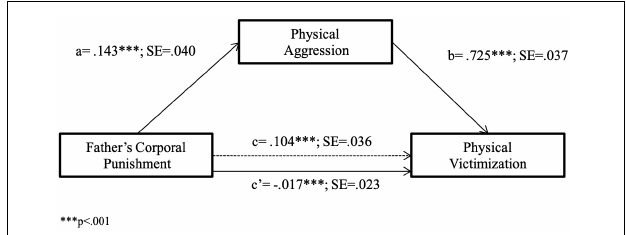
FIGURE 2 | Physical victimization predicted from father’s corporal punishment through physical aggression. *** p < 0.001.